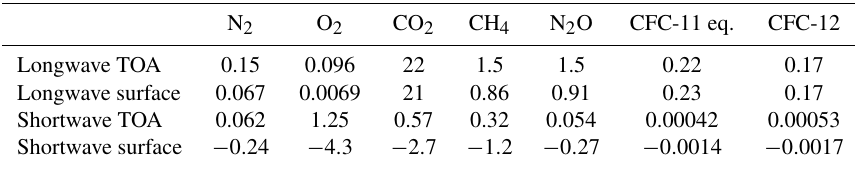
Table 4. Instantaneous radiative forcing at the top of the atmosphere (TOA) and the surface (in Wm − 2 ) of each of the seven well-mixed gases at present-day concentrations, compared to setting their concentration to zero while leaving the other gases unchanged. The values are from LBL radiative transfer calculations using the settings in Sect. 3.5, averaging over the 50 Evaluation-1 profiles. The shortwave calculations are averaged over the five zenith angles so represent a daytime average. Since there is substantial profile-to-profile variation, only two significant digits are shown. N 2 O 2 CO 2 CH 4 N 2 O CFC-11 eq. CFC-12 Longwave TOA 0.15 0.096 22 1.5 1.5 0.22 0.17 Longwave surface 0.067 0.0069 21 0.86 0.91 0.23 0.17 Shortwave TOA 0.062 1.25 0.57 0.32 0.054 0.00042 0.00053 Shortwave surface − 0 . 24 − 4 . 3 − 2 . 7 − 1 . 2